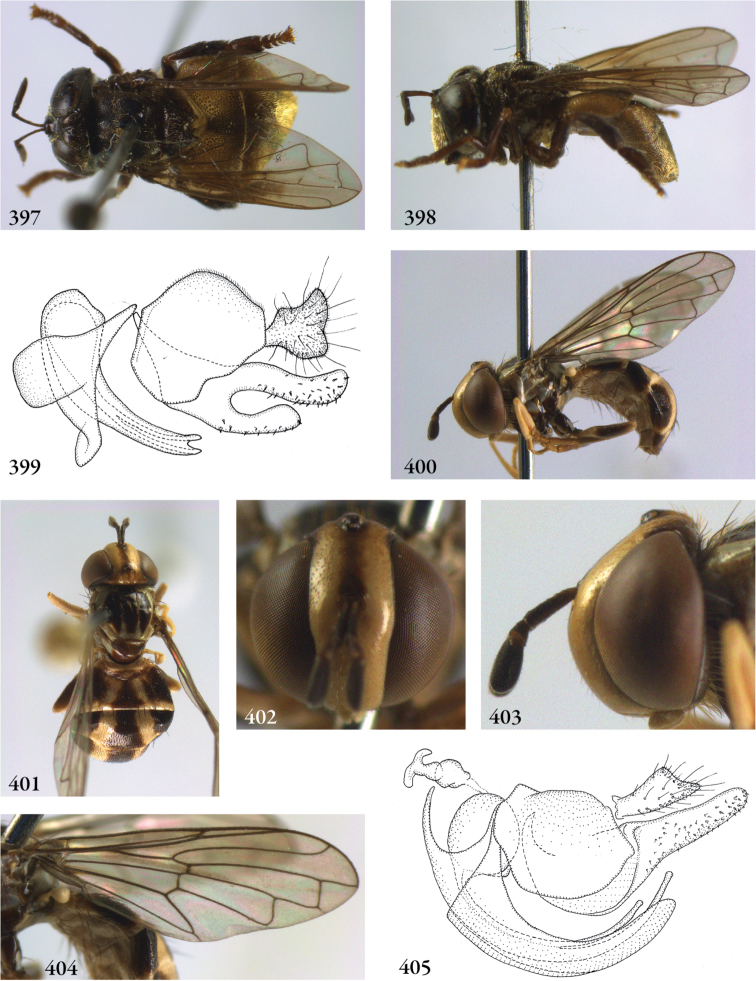
397–399
Sulcodon sulcatus female (Indonesia, Java, coll. RMNH): 397 habitus dorsal 398 habitus lateral 399 genitalia lateral 400–404
Surimyia rolanderi female (Surinam, coll. RMNH): 400 habitus lateral 401 habitus dorsal 402 head frontal 403 head lateral 404 wing 405
Surimyia rolanderi male (holotype), genitalia lateral.